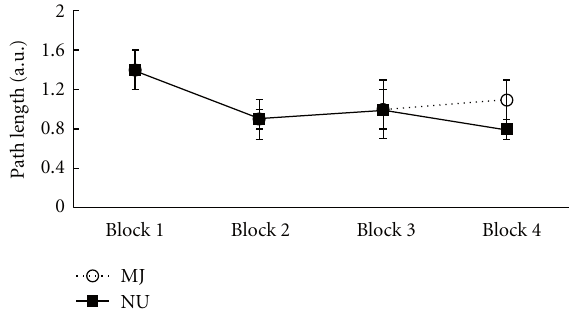
F 3: Average path lengths on WMT hidden trials during the Learning condition in MJ (open circles) and NU (closed squares) groups across trial